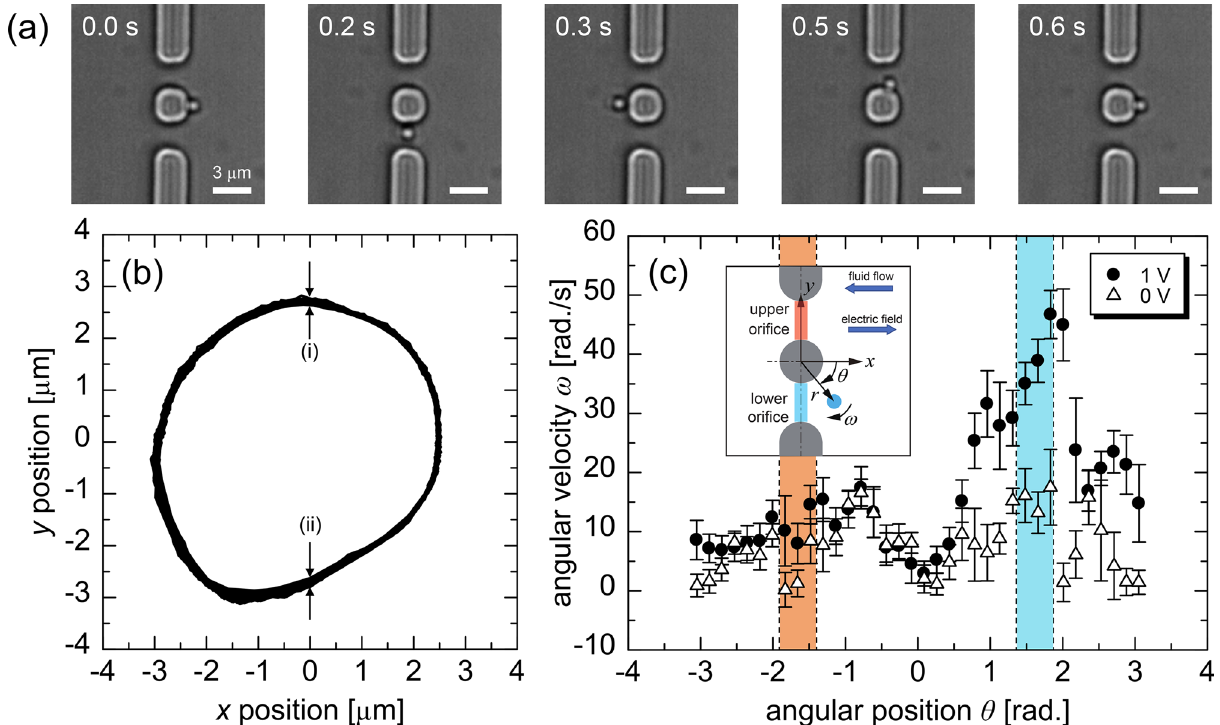
Figure 3. ( a ) Snapshots of the orbital motion of the 1~ µ m PS particle in the double orifice under an applied voltage of 1 V. Scale bars denote 3 µ m. A corresponding video is provided as Movie S1. ( b ) Trajectory of the orbital motion in the double orifice obtained by the particle tracking analysis. (i) and (ii) denote the width of the multiple trajectories in the upper and lower orifices, respectively. ( c ) Angular position dependency of angular velocity of the orbital motion with and without application of a voltage. Each plot and error bars again denote the spatial average and the standard deviation of the angular velocity. The areas colored red and blue correspond to the position of the upper and lower orifices, respectively. The inset shows the definition of each coordinate to the double orifice. In this case, the fluid flow and electric field point in a negative and positive x direction, respectively. The particle motion in the orifice is modulated by the external electric field and fluid flow with a speed of O ( 10 ) µ m/s, showing the different speeds between the upper and lower